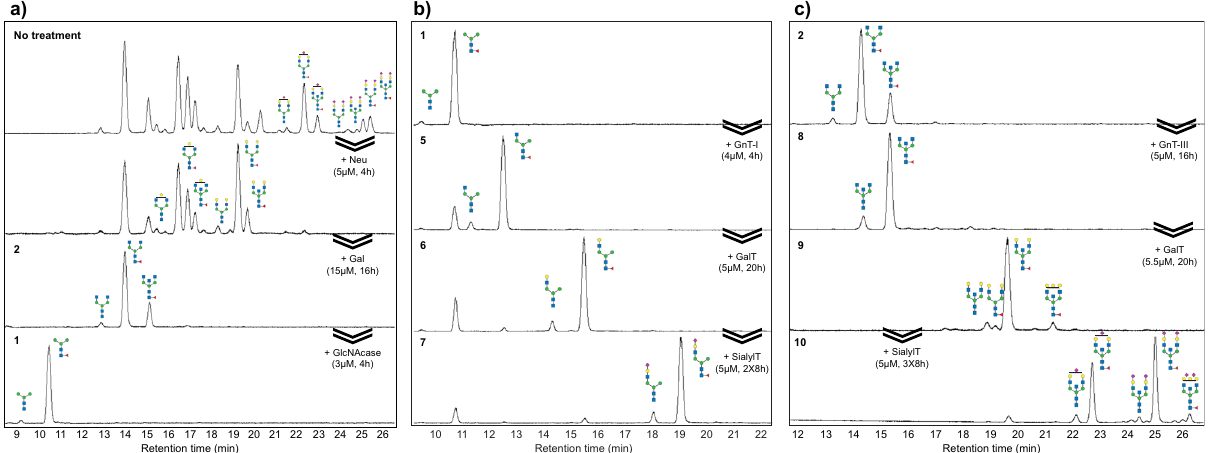
Fig. 3 Glycan chromatograms from IgGs after sequential glycoengineering using SPGR. a Process of remodeling IgG glycans into core saccharides (FM3 and M3 glycoforms). b Process of re-building core saccharides into mono-antennary species. About 10% (F)M3 glycans remained in the products due to the reversible activity of GnT-I. c Process of re-building FA2 and A2 glycans into bisecting species. Refer to Fig. 4 for the sample numbering and Table 1 for the buffer conditions.